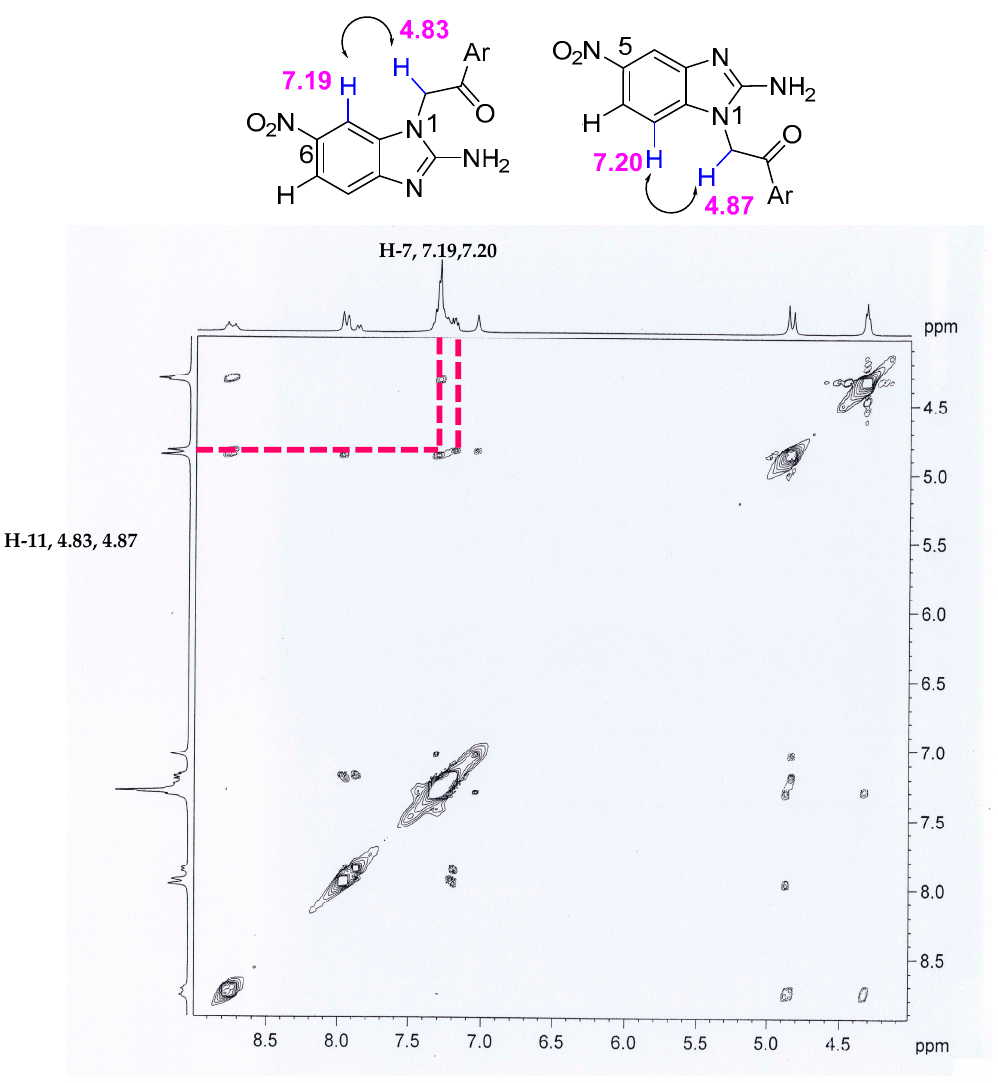
Figure 2. NOESY NMR experiment (mixing time 100 ms, temperature 25 °C, Varian Oxford 400 MHz).